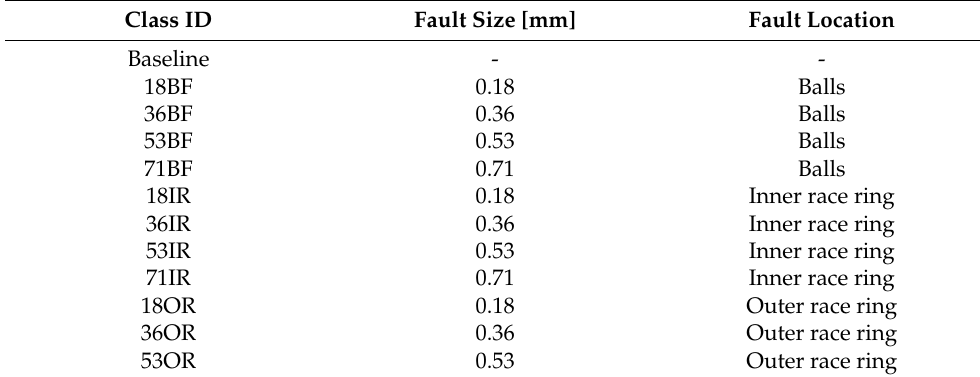
Table 3. CWR classes’